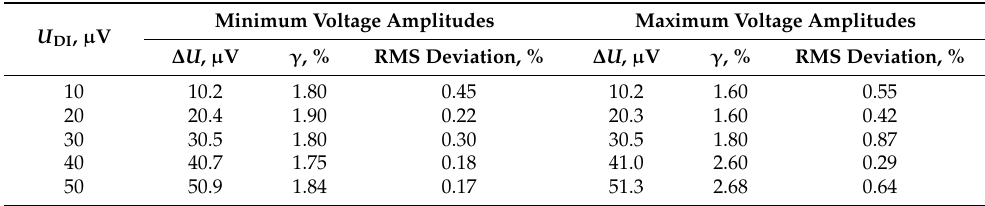
Table 6. Minimum and maximum amplitudes of the compared voltages.